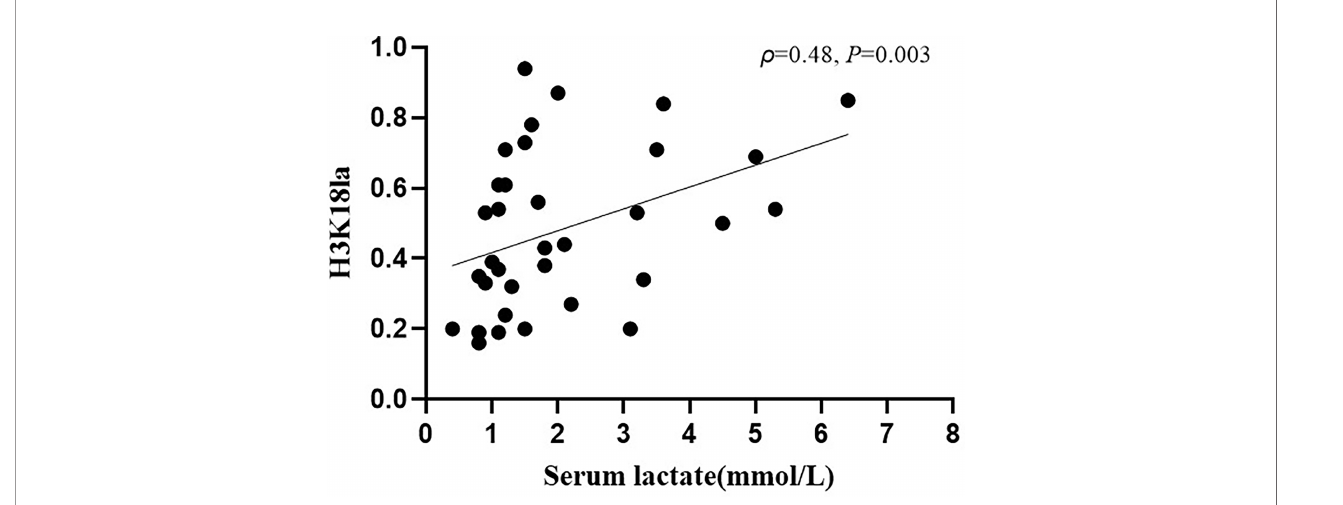
FIGURE 4 | H3K18la lactylation correlation with serum lactate in ICU patients. H3K18la had a positive correlation with serum lactate (Spearman correlation coef fi cient 0.48; P =0.003). H3K18la: The relative density of H3K18 lactylation in western blotting. Serum lactate: Serum lactate level at blood sample date. P values below 0.05 indicate statistical signi fi cance.